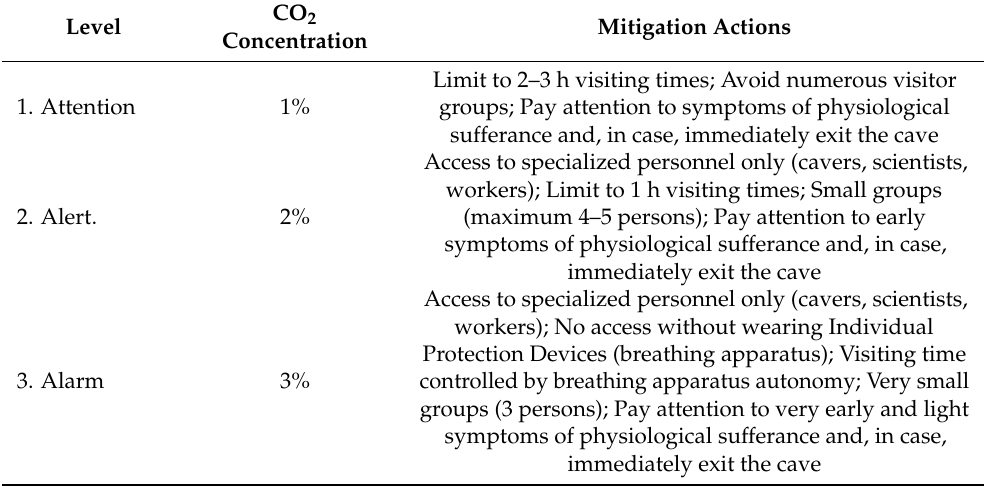
Table 2. Attention, alert and alarm limits based on increasing air CO 2 concentrations and proposed risk mitigation